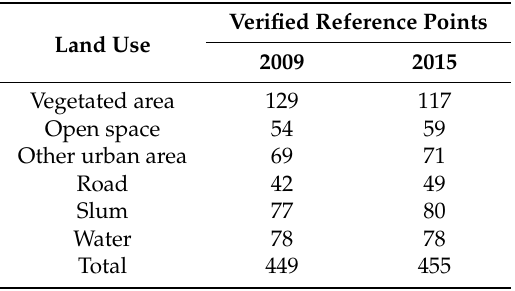
Table 5. Sample sizes allotted to the targeted land use class in 2009 and